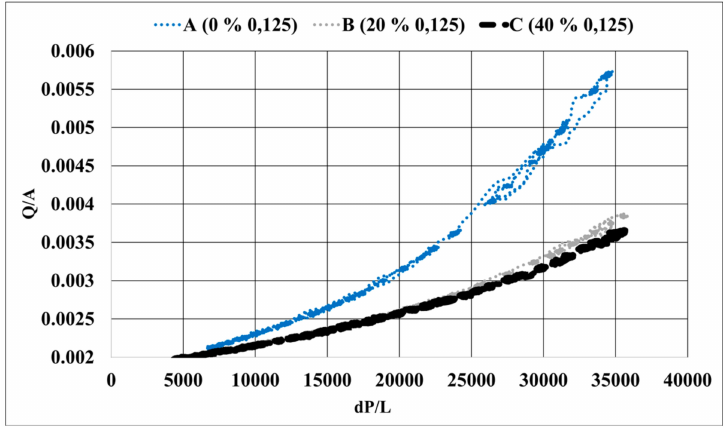
Figure 5. Q/A plotted against dP/L for the three samples